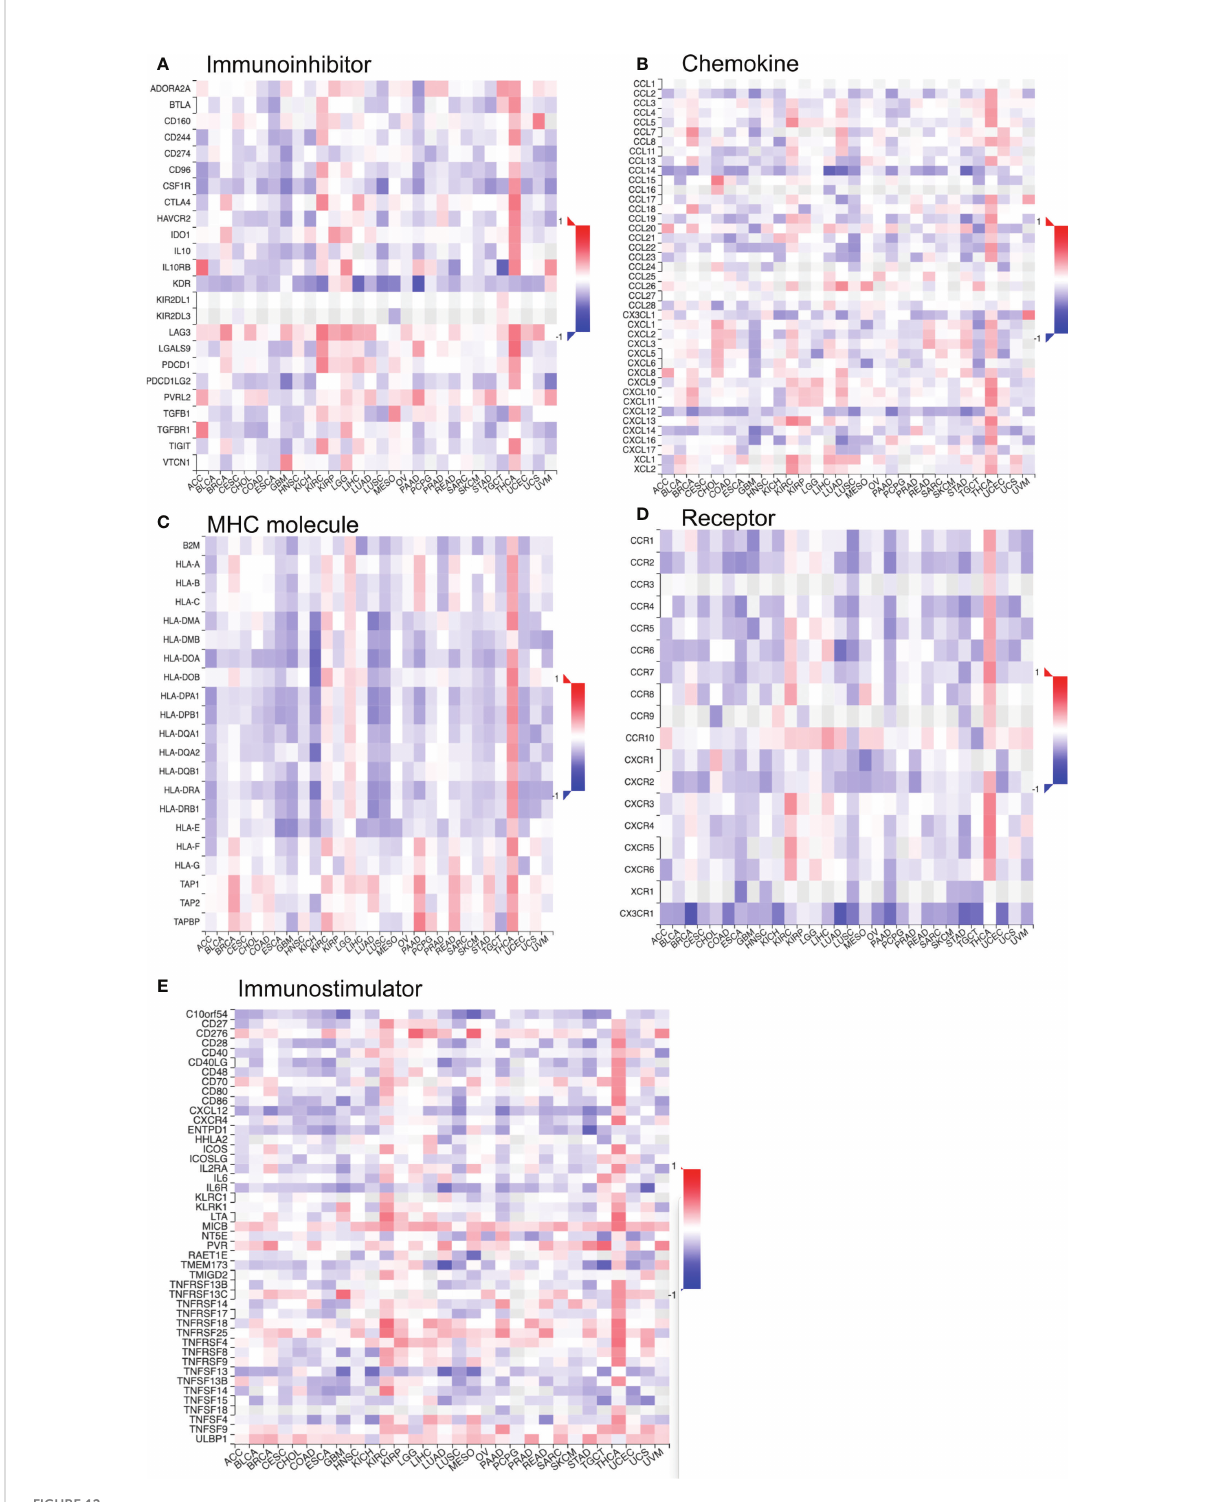
FIGURE 12 The co-expression correlation of TROAP transcriptional expression and gene markers of speci fi c immune-regulated gene sets in pan-cancer. (A) Immunoinhibitor. (B) Chemokine. (C) Major histocompatibility complex (MHC) Molecules. (D) Chemokine receptor. (E) Immunostimulator. Red and blue color represented the positive and negative correlation, respectively. And the degree of color from dark to light presented the correlation gradually changed from strong to